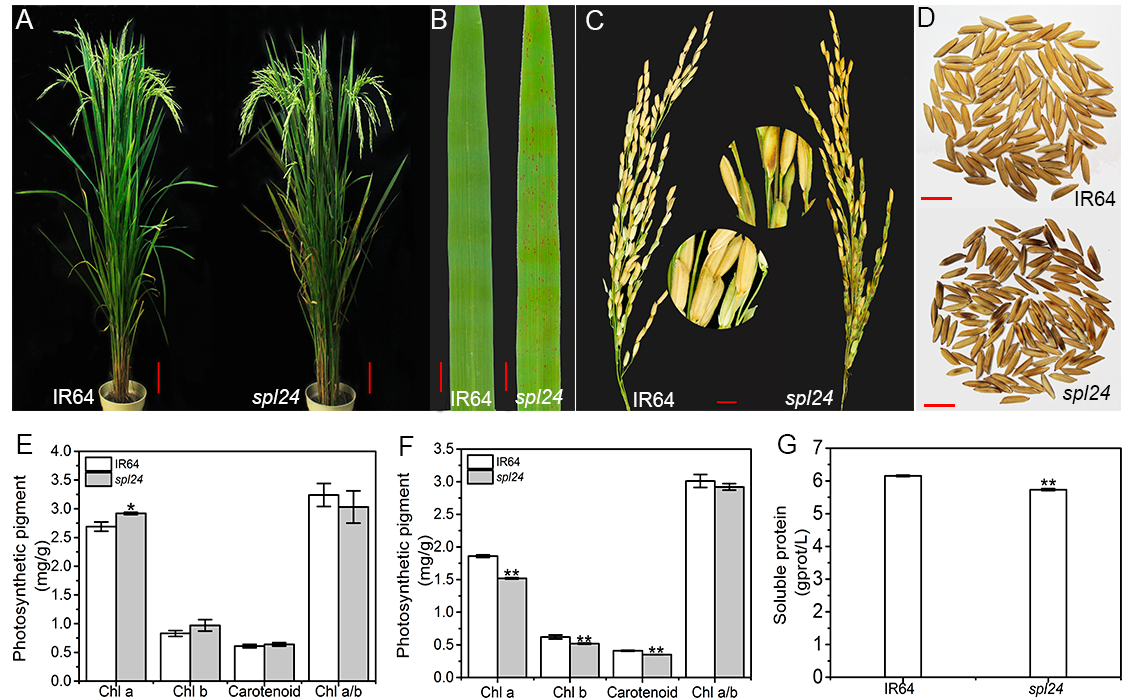
Figure 1. Phenotypic characteristics of spl24 and the wild-type IR64. ( A ) Mature plant, bar = 10 cm; ( B ) Leaf of IR64 and spl24 ; bar = 1 cm; ( C ) panicle of IR64 and spl24 , bar = 1 cm; ( D ) grains of IR64 and spl24 ; bar = 1 cm; ( E ) photosynthetic pigment contents of IR64 and spl24 at the tillering stage; ( F ) photosynthetic pigment contents of IR64 and spl24 at the heading stage; ( G ) soluble protein content of IR64 and spl24 at the heading stage. Values are means ± SD ( n = 3); ** indicates significance at p ≤ 0.01 and * indicates significance at p ≤ 0.05 by Student’s t test. Table 1. Performance of agronomic traits in IR64 and spl24.